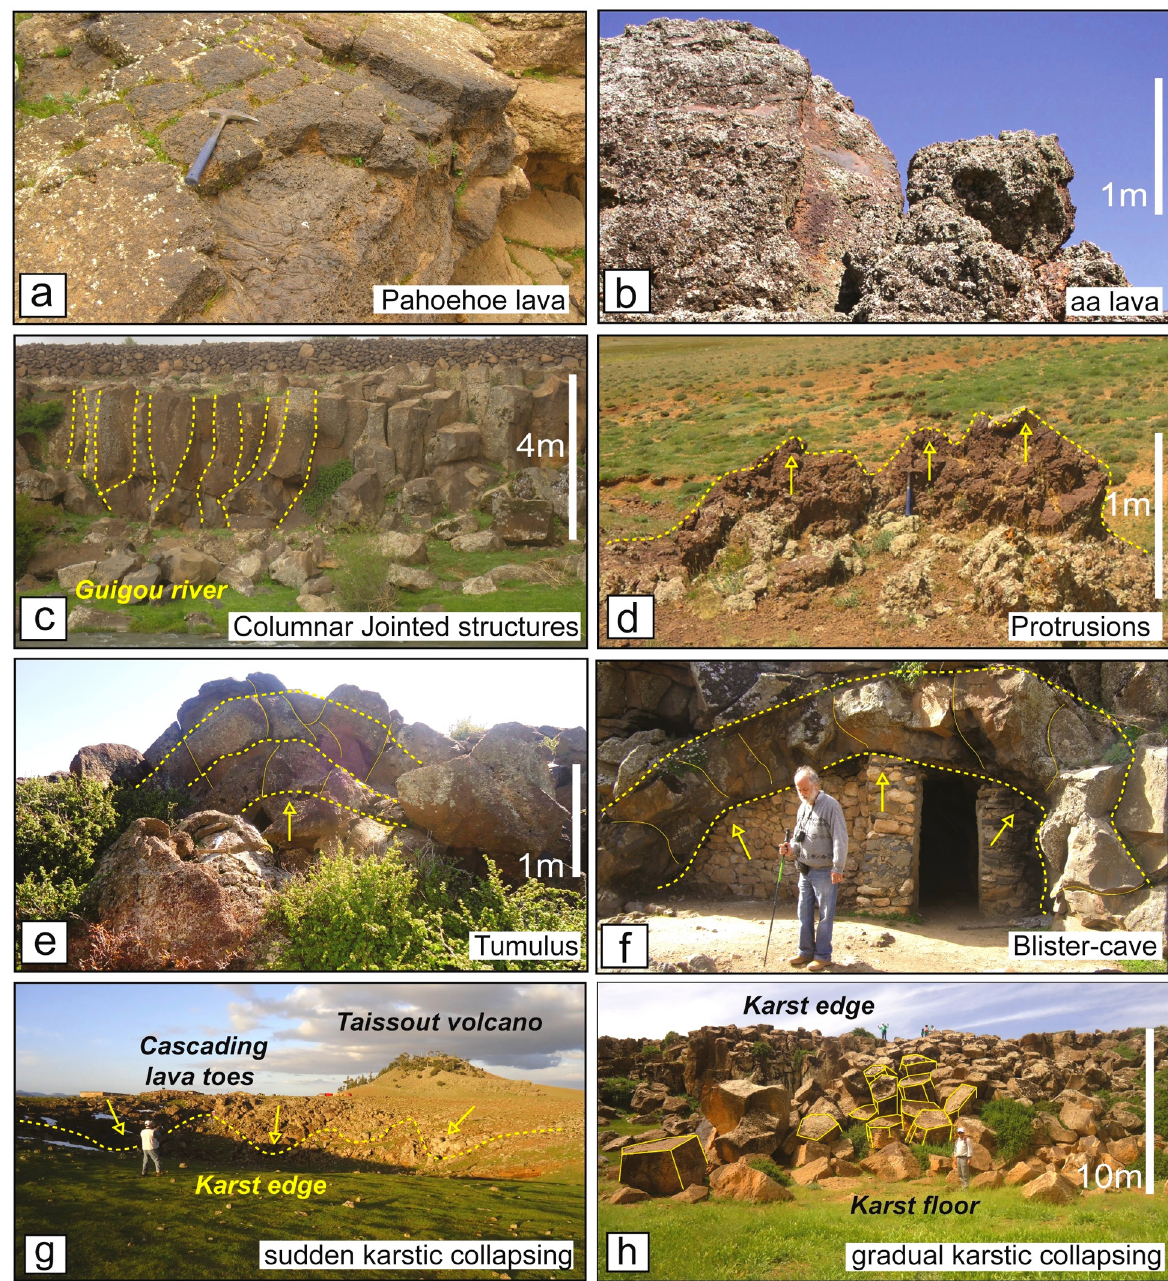
Fig. 3. Main eruptive landforms and structures of lava flow